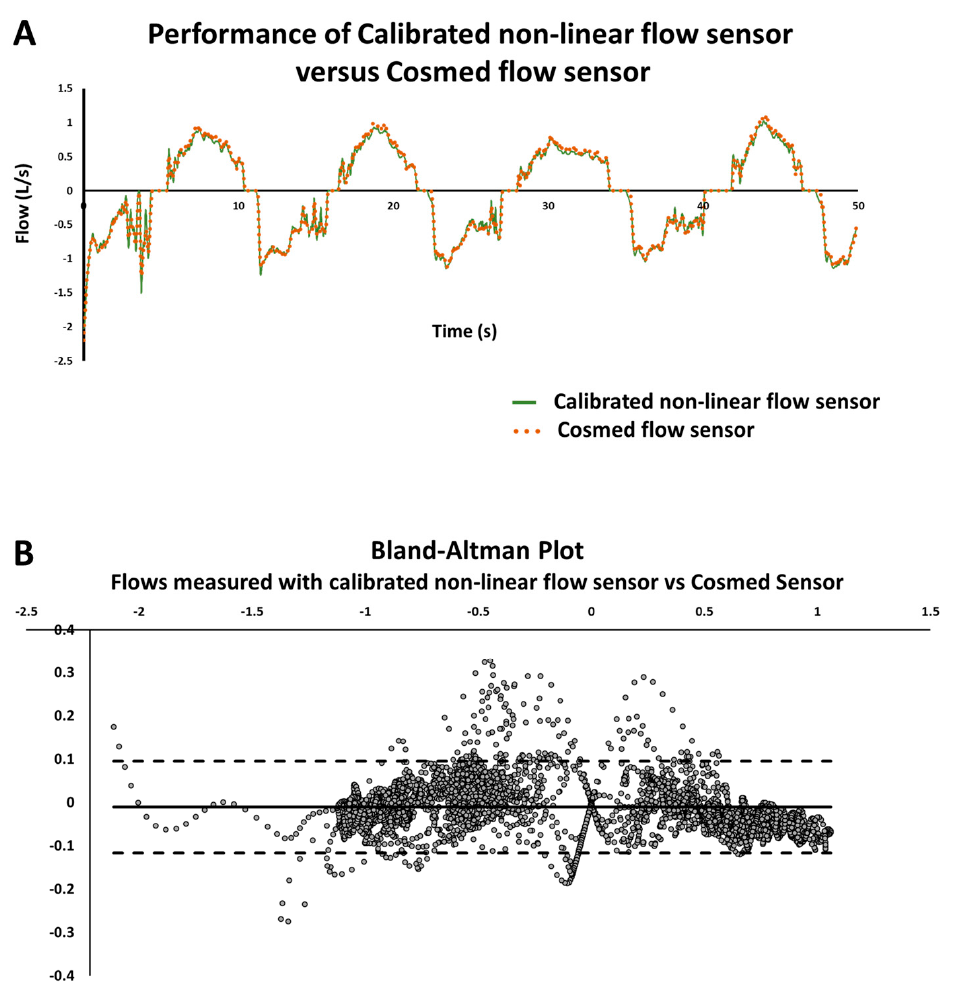
Figure 3. Comparison of calibrated nonlinear flow sensor with Cosmed flow sensor (converted to ambient conditions of pressure, temperature, and humidity). ( A ) Shows the performance of both flow sensors over time in a series of strokes generated with the 3 L calibration syringe. ( B ) Presents data recorded above displayed in a Bland–Altman plot. Each point represents the difference in flows measured with both sensors versus the average flow between both devices. The solid line represents bias, while the dashed lines represent limits of agreement (1.96 SD of differences from the bias).